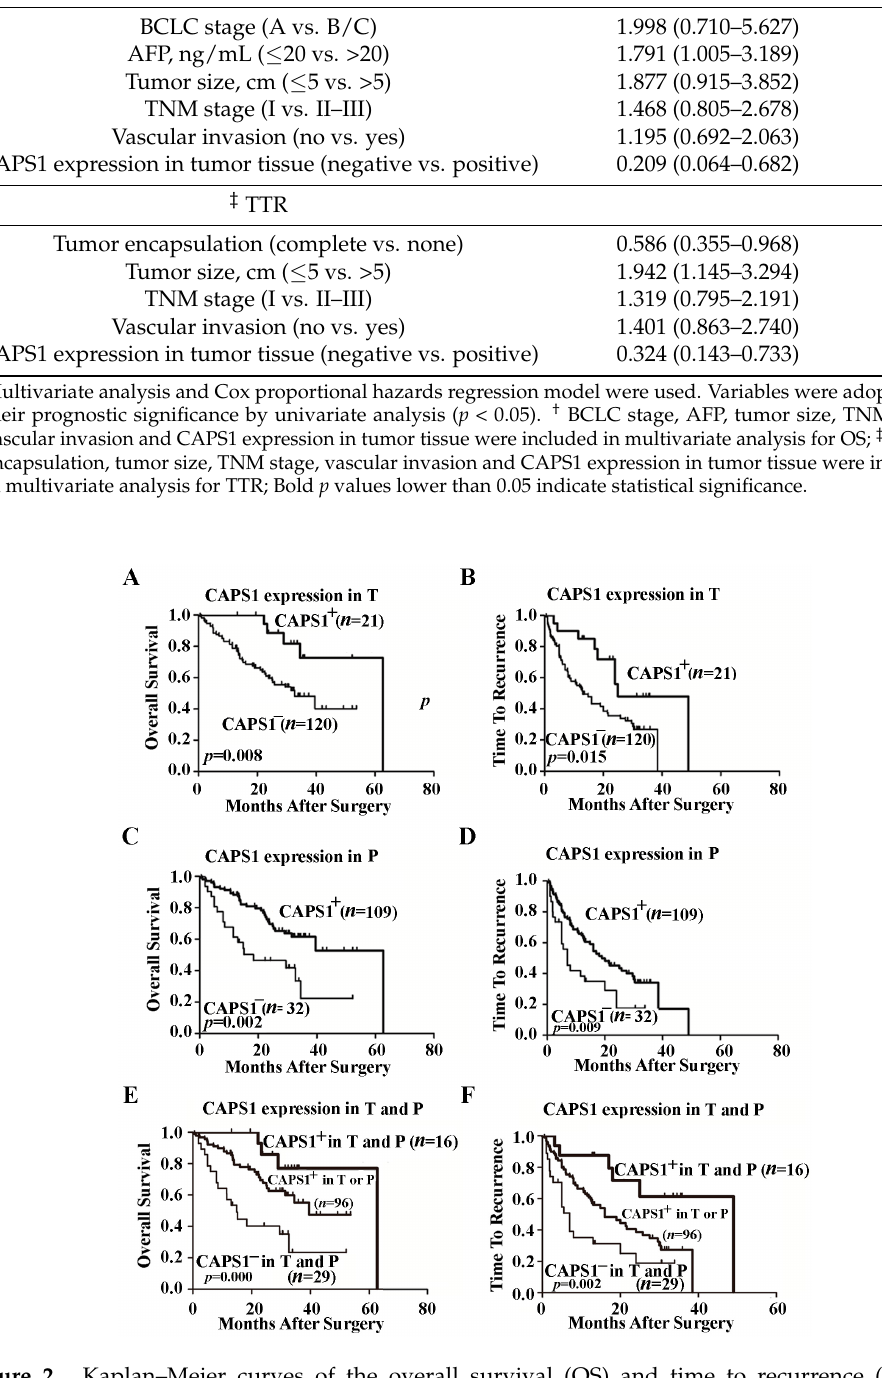
Figure 2. Kaplan–Meier curves of the overall survival (OS) and time to recurrence (TTR) of 141 HCC patients who underwent curative surgery ( p values were obtained by log-rank test).